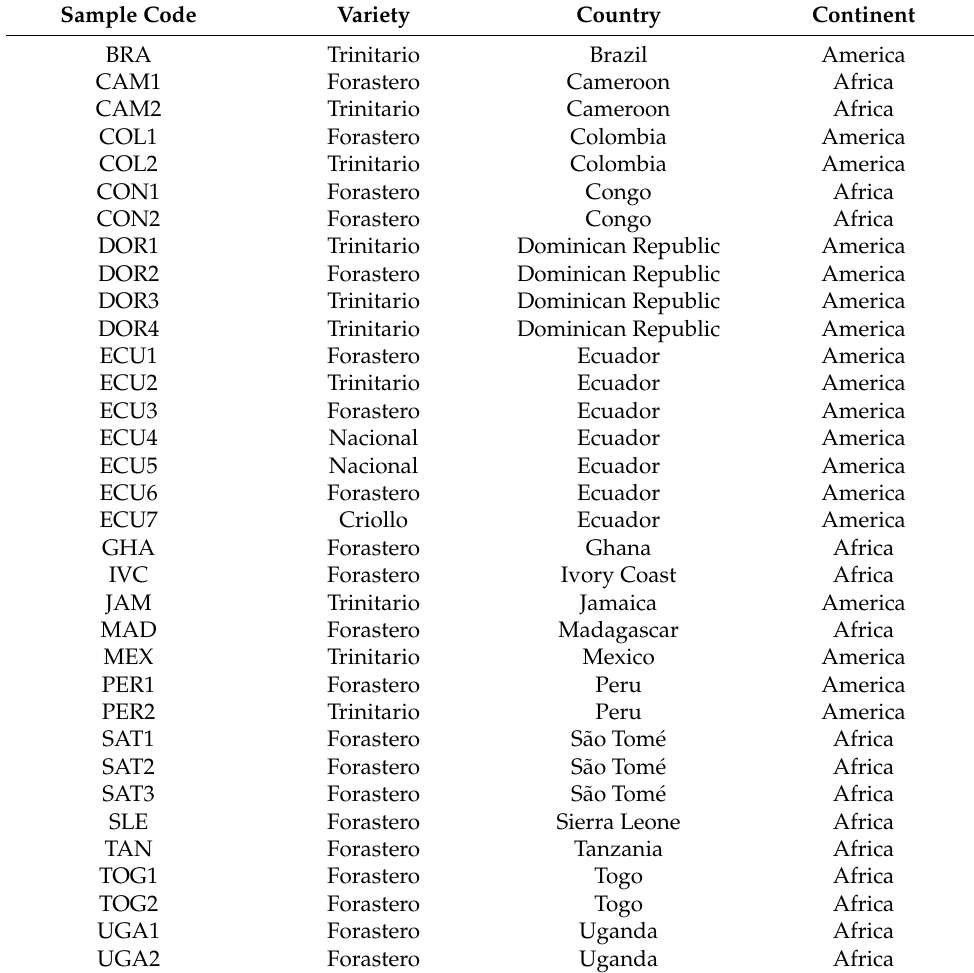
Table 1. Origin of fermented and dried cocoa beans used to yield cocoa bean